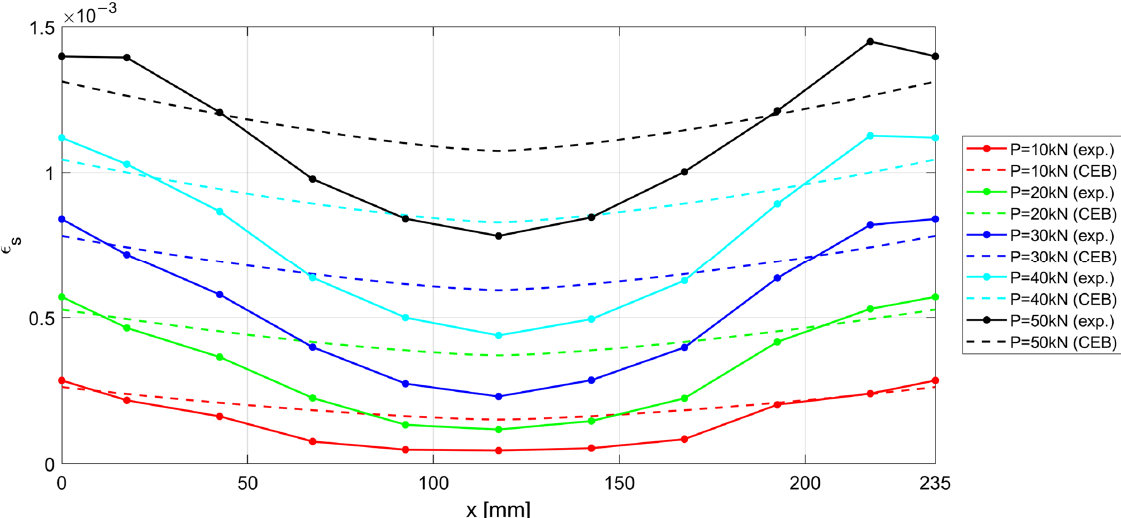
Figure 17. Experimental and numerical ε − x for increasing load P .